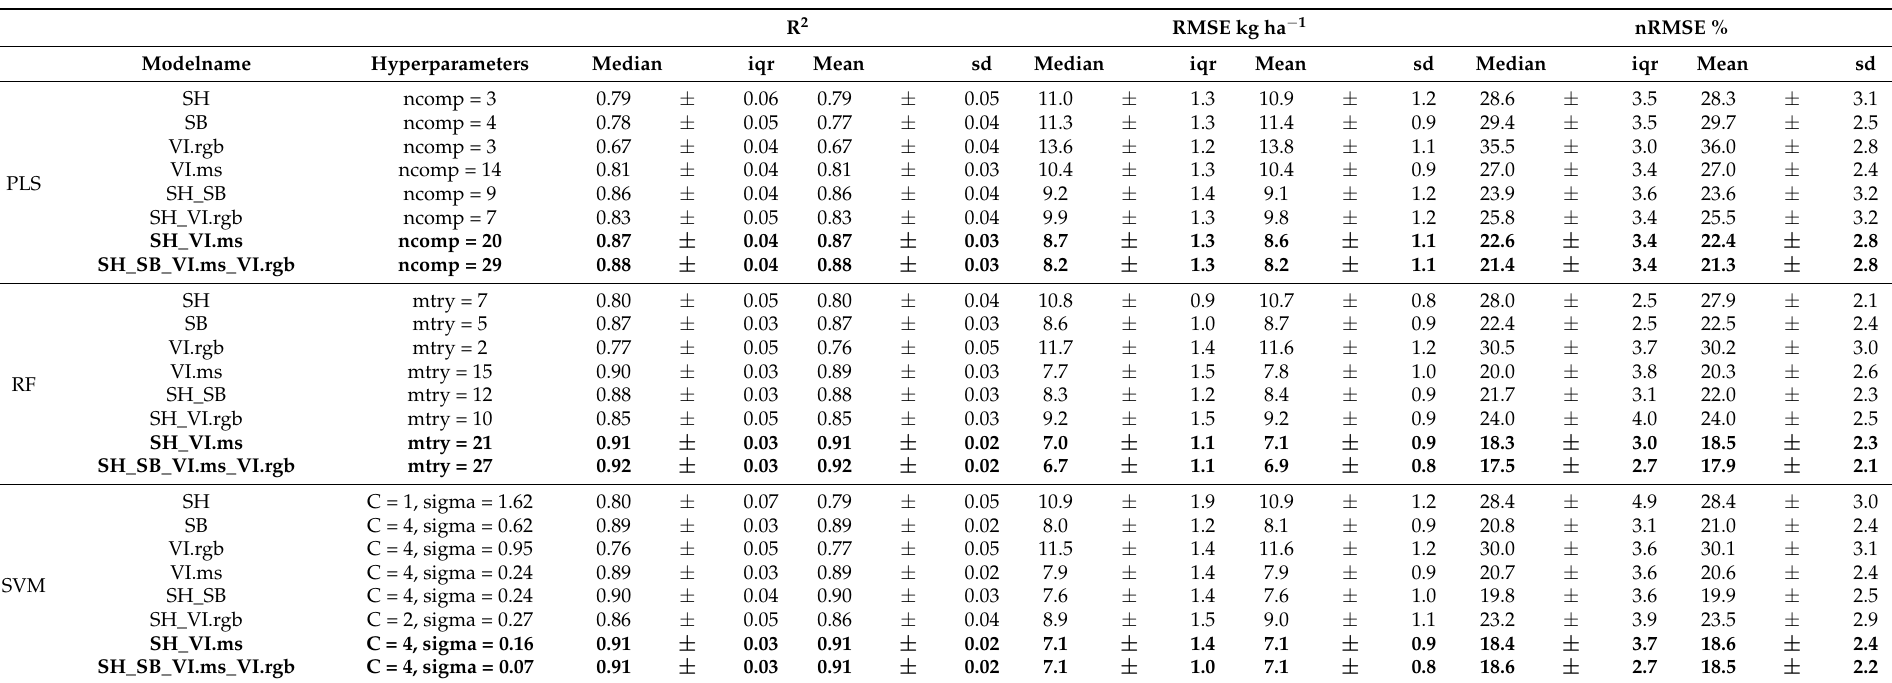
Table A4. Cross-validation results for Nup estimation using PLS, RF and SVM regression (nRMSE normalized via mean observed value). Bold highlights indicate two best models per algorithm. iqr: interquartile range, sd: standard